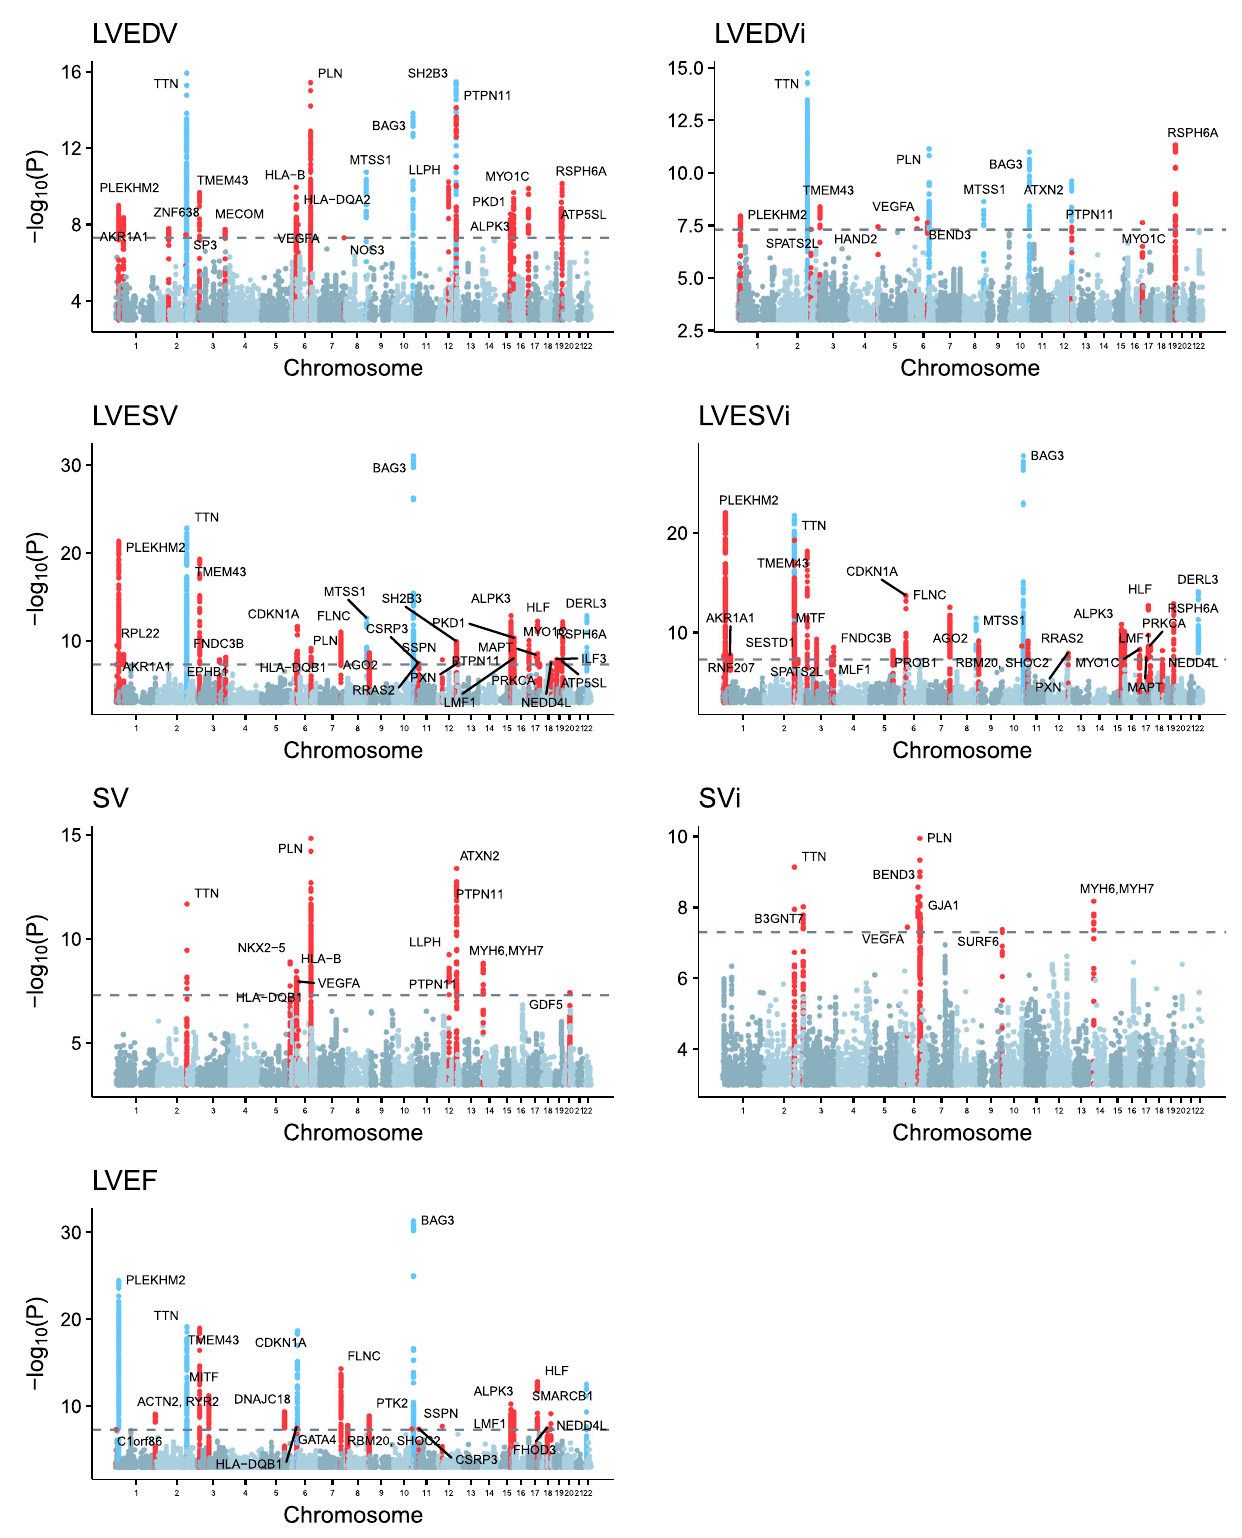
Fig. 1 Manhattan plots of genome-wide association discovery analyses of cardiac MRI phenotypes. For each cardiac MRI phenotype, the − log10( P value) is graphed on the y axis at each chromosomal position on the x -axis. P is the BOLT-LMM P value. The nearest gene to each genome-wide signi fi cant lead SNP is labeled at each locus, except when a cardiomyopathy-related gene is present within 500 kb of the lead SNP. SNPs are colored blue near loci that have previously been observed in common genetic analyses using cardiac traits (TTE or cardiac MRI). SNPs are colored red near loci that were previously